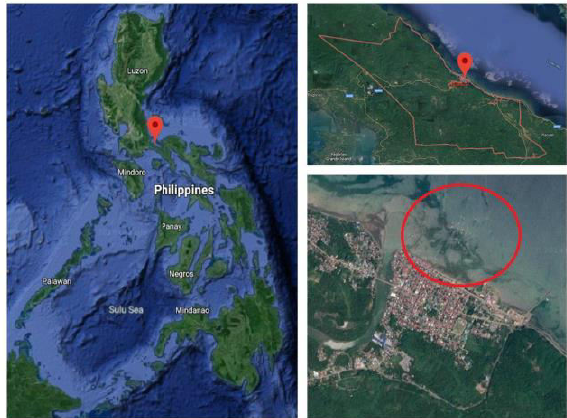
Figure 3 . Satellite images of Atimonan, Philippines (taken from Google Earth Pro) located on 13.9985°N, 121.9195°E. Encircled area represents the potential area to be reclaimed, and the city center is located on South of it.